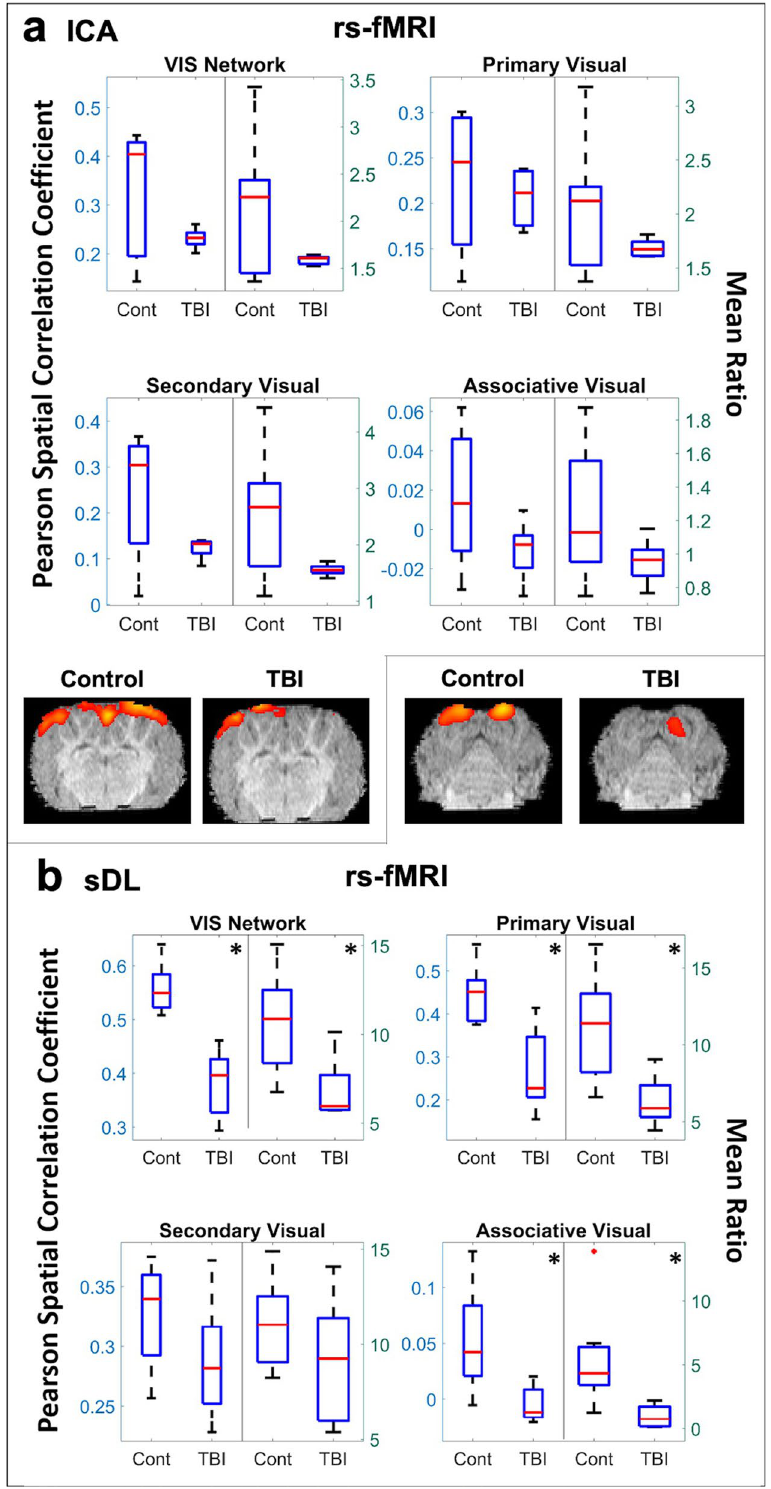
Figure 3. Resting-state (rs-) analysis of the visual (VIS) network. Boxplots of Pearson spatial correlation coefficients (left) and mean ratios (right) obtained from rs- analysis for the VIS network and its individual anatomical regions obtained using independent component analysis (ICA; a ) and sparse dictionary learning (sDL; b ). The red line denotes the median, the blue box denotes the interquartile range, and the lower and upper whiskers denote the min and max, respectively. An asterisk (*) or pound (#) in the upper right-hand corner indicates significant decrease or increase (p < 0.05), respectively, for the TBI group in comparison to the control group. Representative axial plane activation maps overlaid on the template pigs’ T1-weighted anatomical image are also displayed. Representative maps in the coronal and sagittal plane are provided in the Figures S4 and